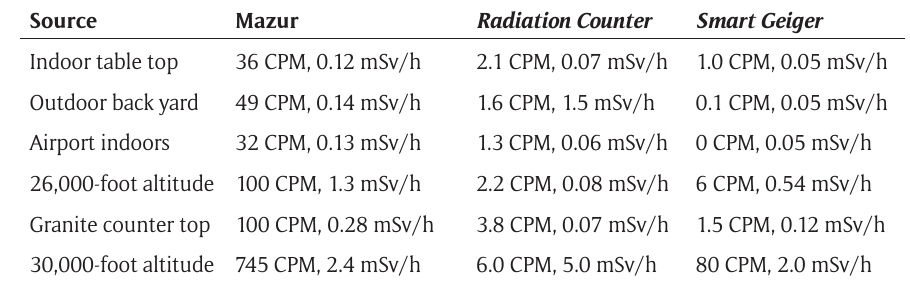
Table 2: Representative environmental radiation dosages with smartphone back